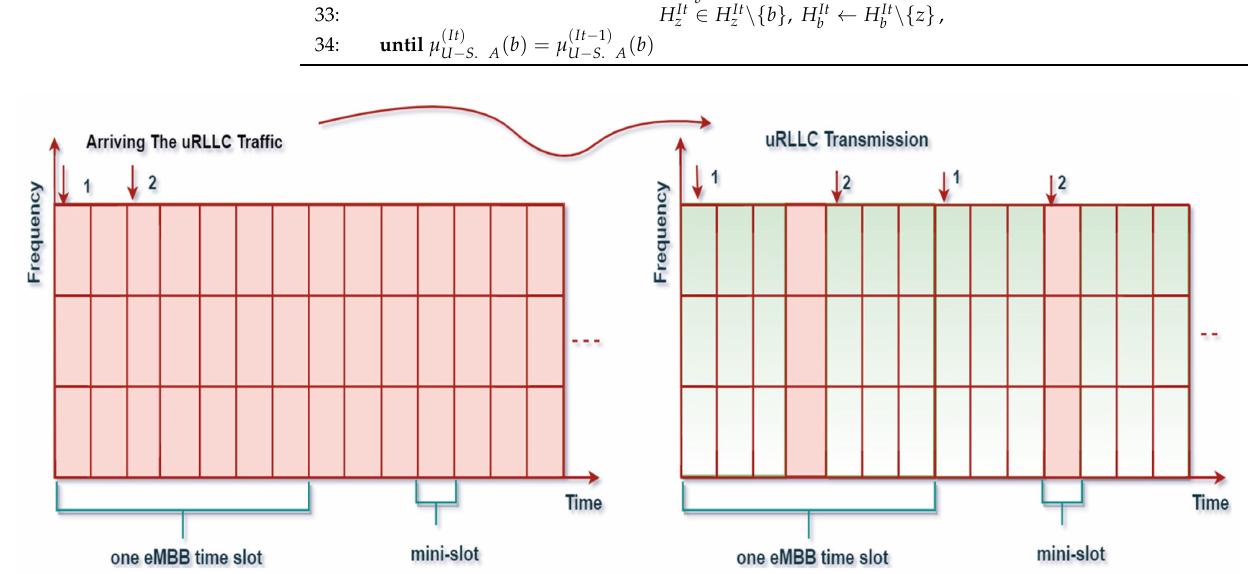
Figure 4. Illustration of the proposed heterogeneous- NS(HNS)